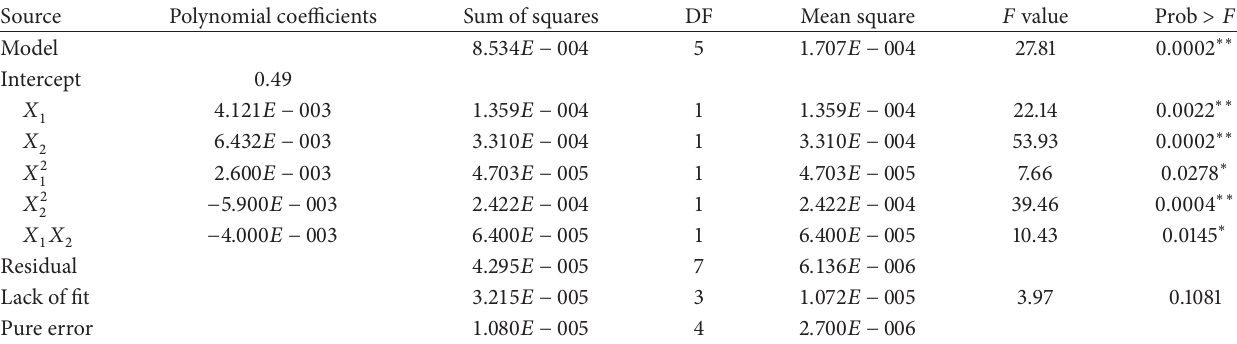
Table 6: Analysis of variance for the quadratic polynomial model of GLA content produced by Cunninghamella bainieri 2A1.